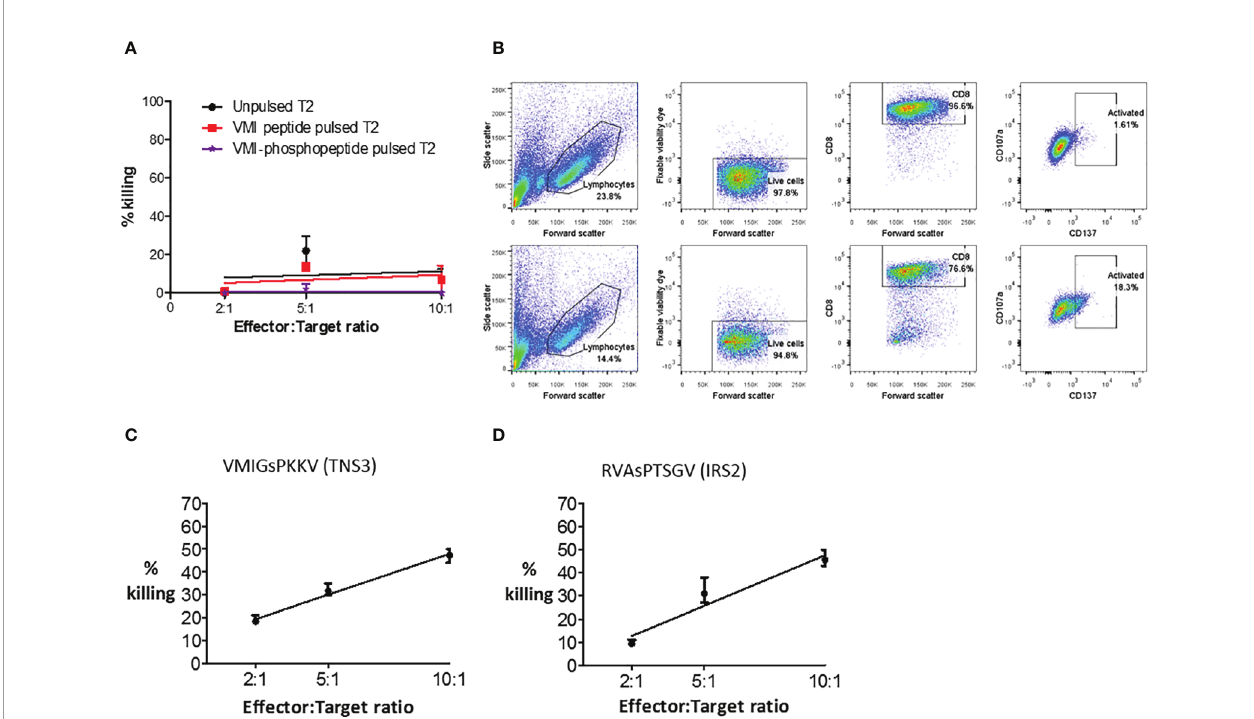
FIGURE 5 | Phosphopeptide-speci fi c T cells can kill, but expanded TILs do not. (A) A europium release assay, using a VMI-speci fi c T cell line grown from patient (CRC5) TILs to target T2 cells pulsed with phosphopeptide VMIGsPKKV, or unphosphorylated VMIGSPKKV. (B) Flow cytometry to show the activation and degranulation of VMI-speci fi c CRC5 TILs when stimulated with unphosphorylated VMIGSPKKV (top) and phosphorylated VMIGsPKKV (bottom). Healthy donor T cell lines targeting (C) VMIGsPKKV and (D) RVAsPTSGV were used in a europium-release killing assay with a CRC cell line natively expressing the phosphopeptides (SW620).